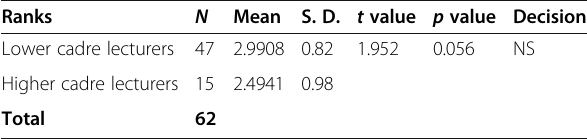
Table 4 Independent sample t test of the two categories of lecturers on perceived versatility of graduates of the program Ranks